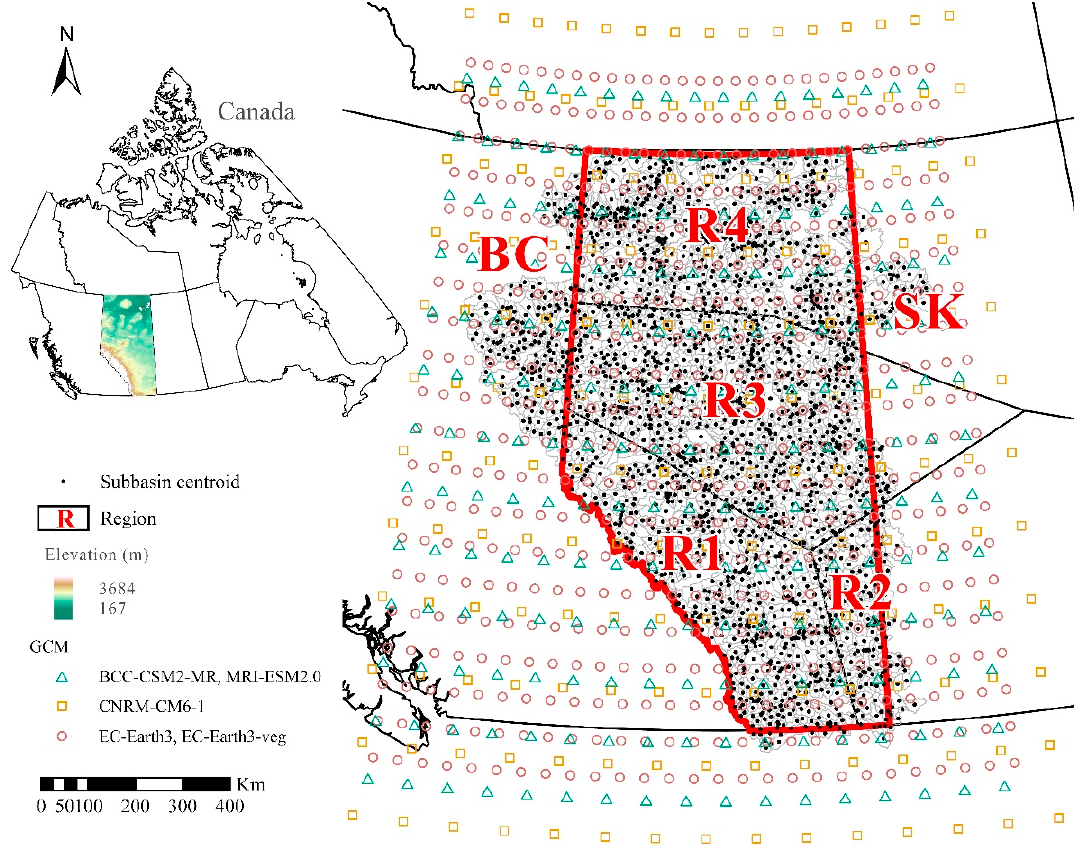
Figure 1. Map of Alberta with its four extreme climate regions (R1; R2; R3; and R4) overlaid with grid locations of five GCMs selected for the study. The black dots indicate a centroid of 2255 sub-basins. The inset shows the location of Alberta in Canada and its topography.